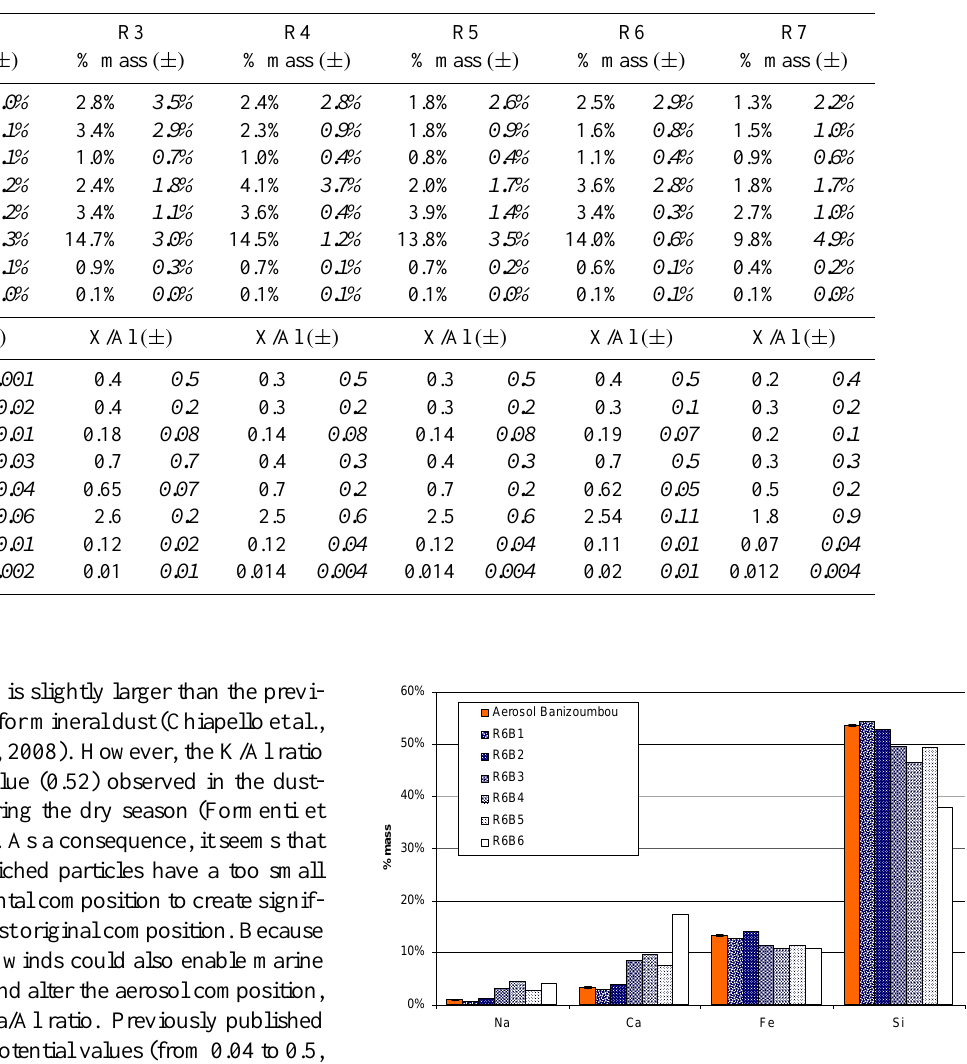
Fig. 4. Comparaison between total elemental content in collected Figure 4 : Comparaison between total elemental content in collected samples for the rain R6 samples for the rain R6 (14 July 2006) and in emitted local dust (14/07/2006) and in emitted local dust extracted from Formenti et al. (2008). extracted from Formenti et al.